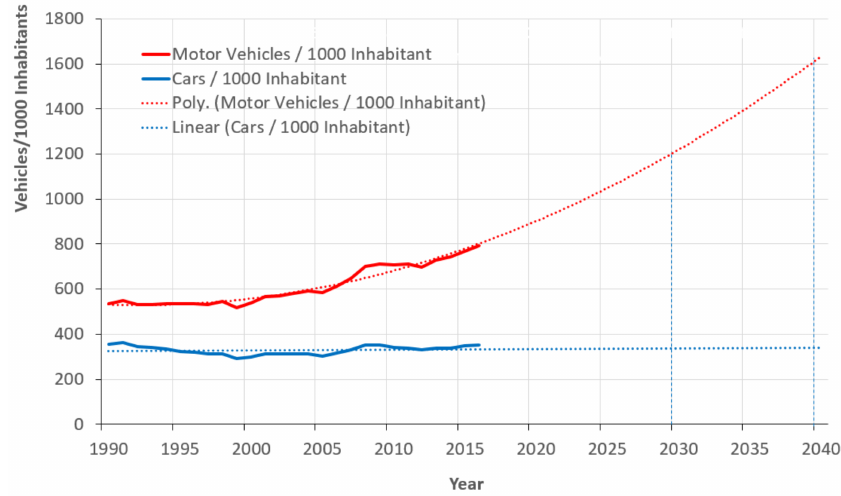
Figure 3. B.C. Motor vehicle stock and car stock per 1000 B.C. inhabitants, data from [33,38].